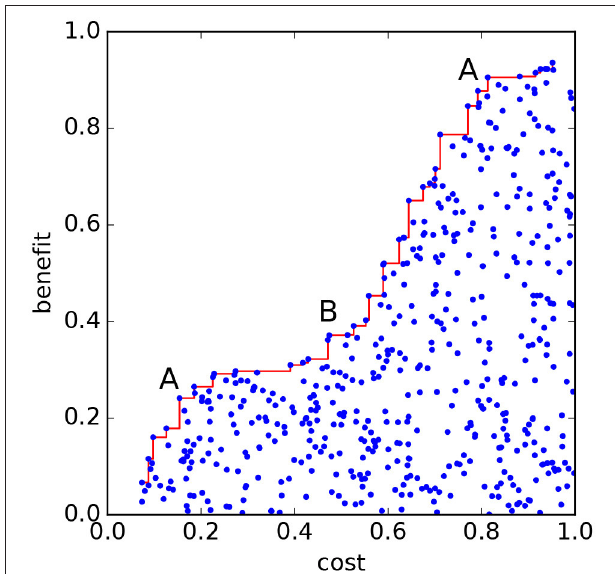
FIGURE 1 | Schematic of a Pareto front (red line), with a function to be minimized (labeled “cost”) on the x − axis and a second function (labeled “benefit”), to be maximized, on the y − axis. Each blue dot represents a possible solution. The points along the Pareto front are Pareto-optimal solutions from which the benefit cannot be increased without increasing the cost; and cost cannot be reduced without reducing benefits. Convex sections of the front (“A”) represent locally preferred solutions. Concave sections (“B”) represent locally poorer